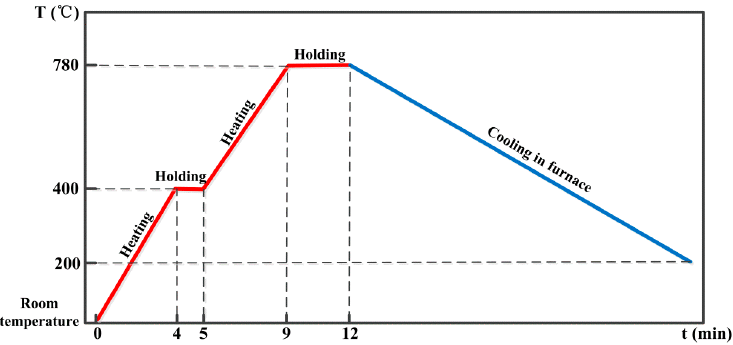
Figure 1. Sintering process route.